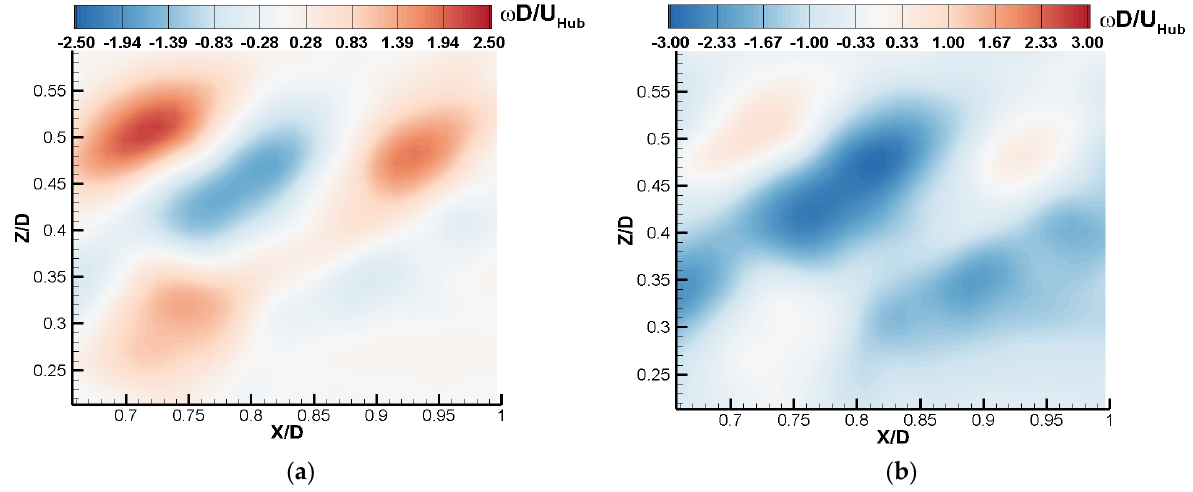
Figure 18. Vorticity-based POD reconstructions for X > 0.65 D (R2). ( a ) 𝑎 (cid:2869) ∅ (cid:2869) + … + 𝑎 (cid:2874) ∅ (cid:2874) . ( b ) 𝑎 (cid:2869) ∅ (cid:2869) + … + 𝑎 (cid:2874) ∅ (cid:2874) +